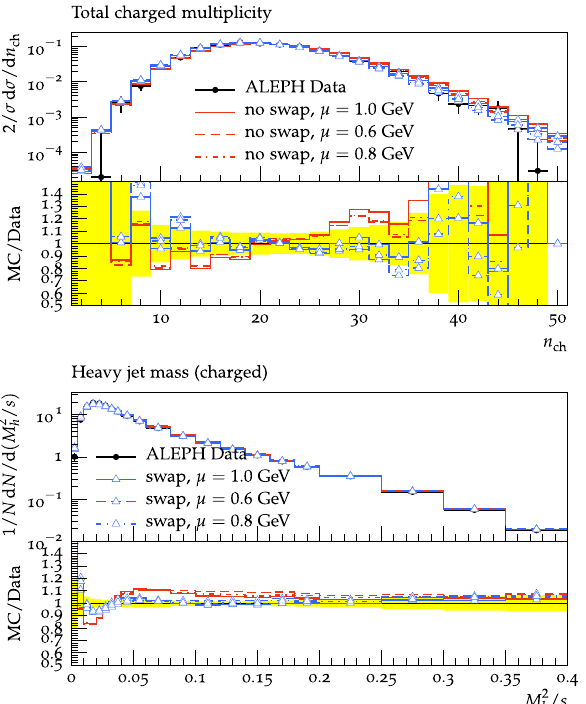
Fig. 2 Upperplot:thetotalchargemultiplicityasmeasuredbyALEPH Collaboration [30]. Lower plot: The heavy jet mass measured by ALEPH Collaboration [31]. For simulation setup see Sect. 5